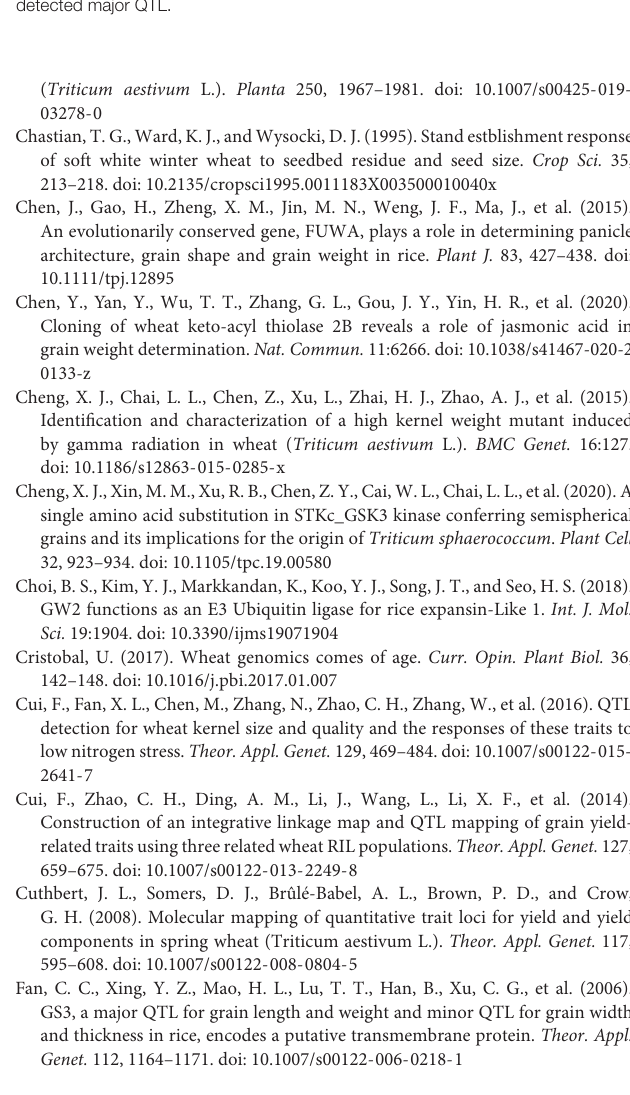
in 2SY population.